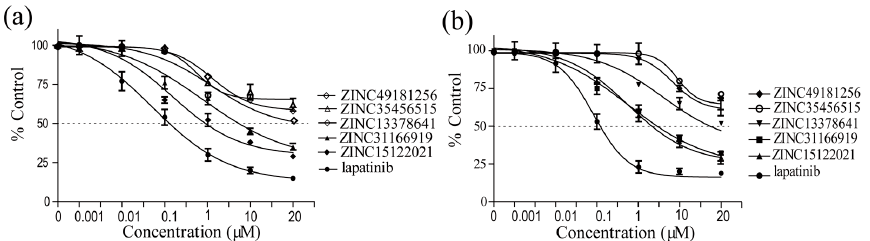
Figure 4. Dose-response effect of selected compounds on breast cancer cell lines, ( a ) SKBR3 cell line; ( b ) BT474 cell line. Results are expressed as the mean percentage of control plates containing no drug. Error bars correspond to SD (standard deviations) from three independent measurements. Table 4. The IC 50 (half maximal inhibitory concentration) values of selected natural compounds against HER2 kinase and HER2-overexpressing SKBR3 and BT474 cell lines. The values represented the mean ˘ SD (standard deviations) of at least three independent experiments.